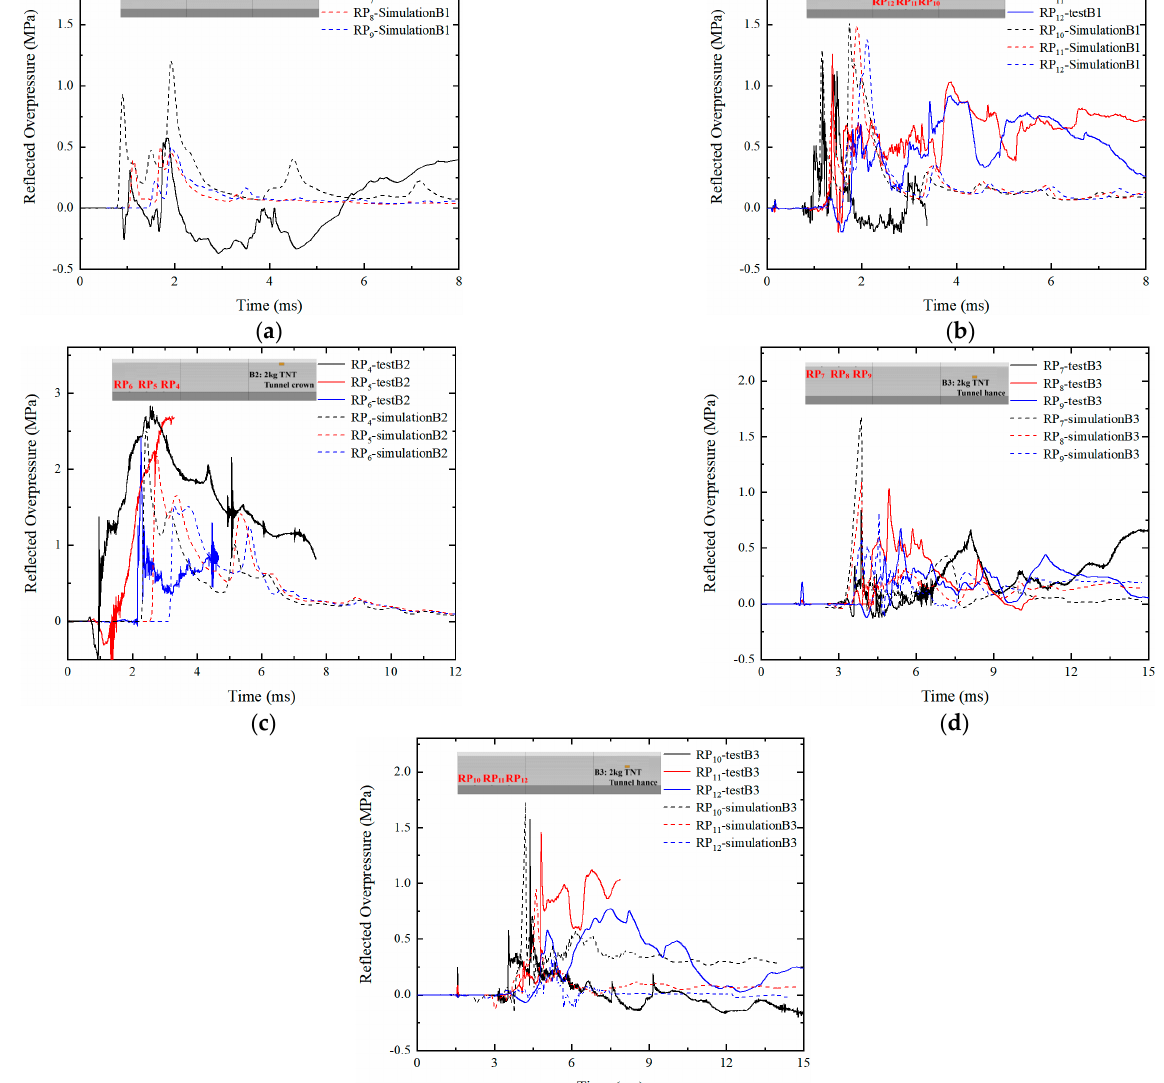
Figure 8. Time histories of reflected overpressure: ( a , b ) Case B1; ( c ) Case B2; ( d ) and ( e ) Case